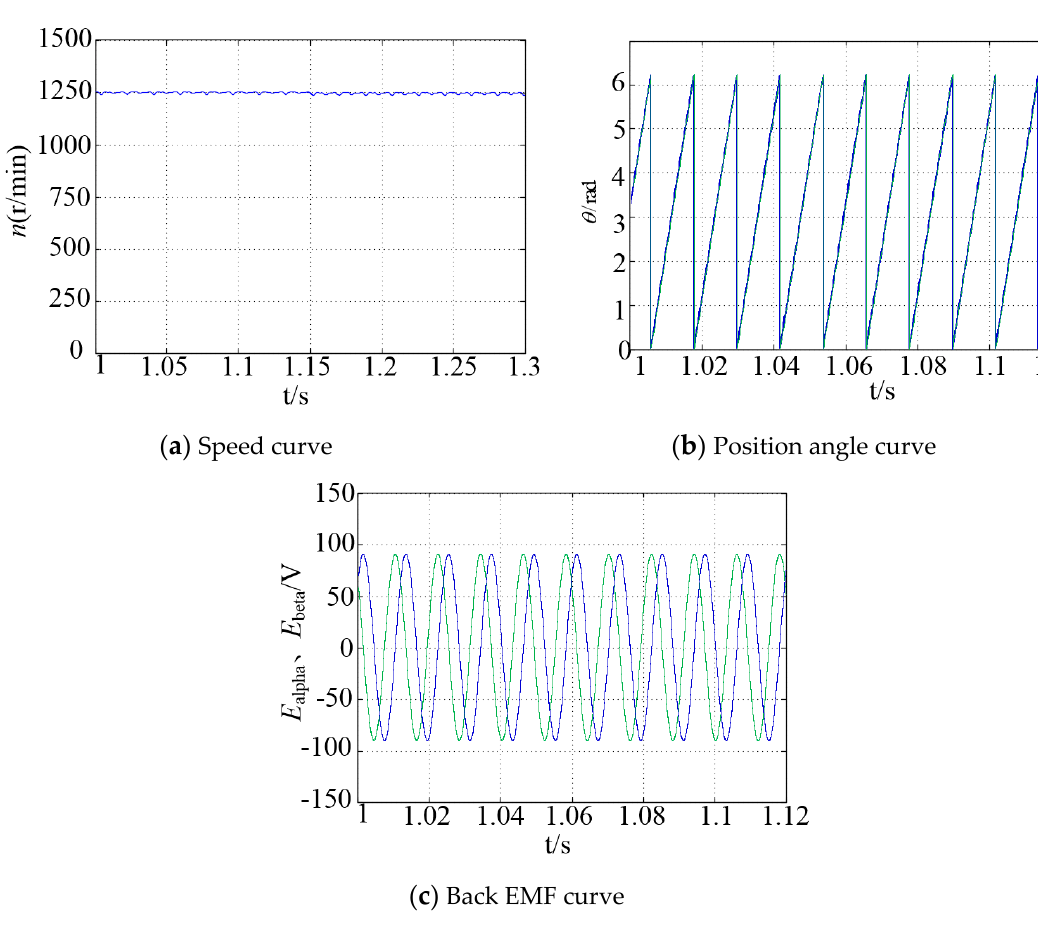
Figure 7. Simulation curves of steady state of an STA-SMO.